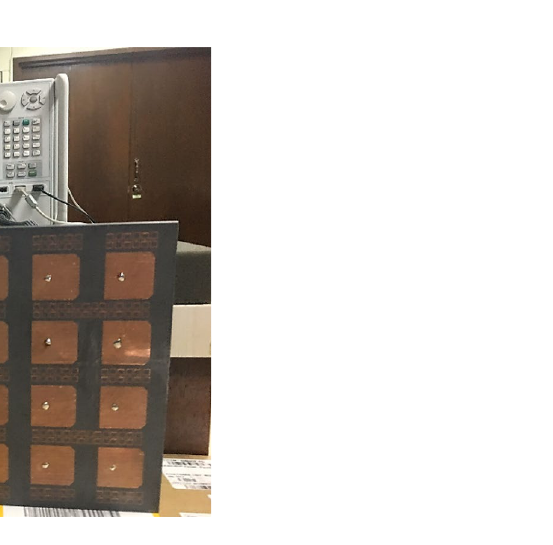
Figure 12. Setup for measuring the fabricating